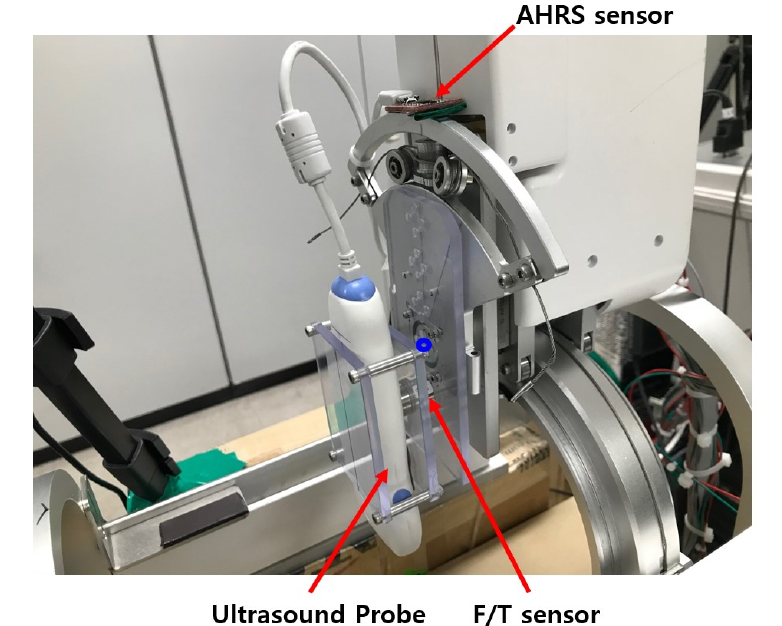
Figure 4. Sensors in the upper part of sarcopenia detection